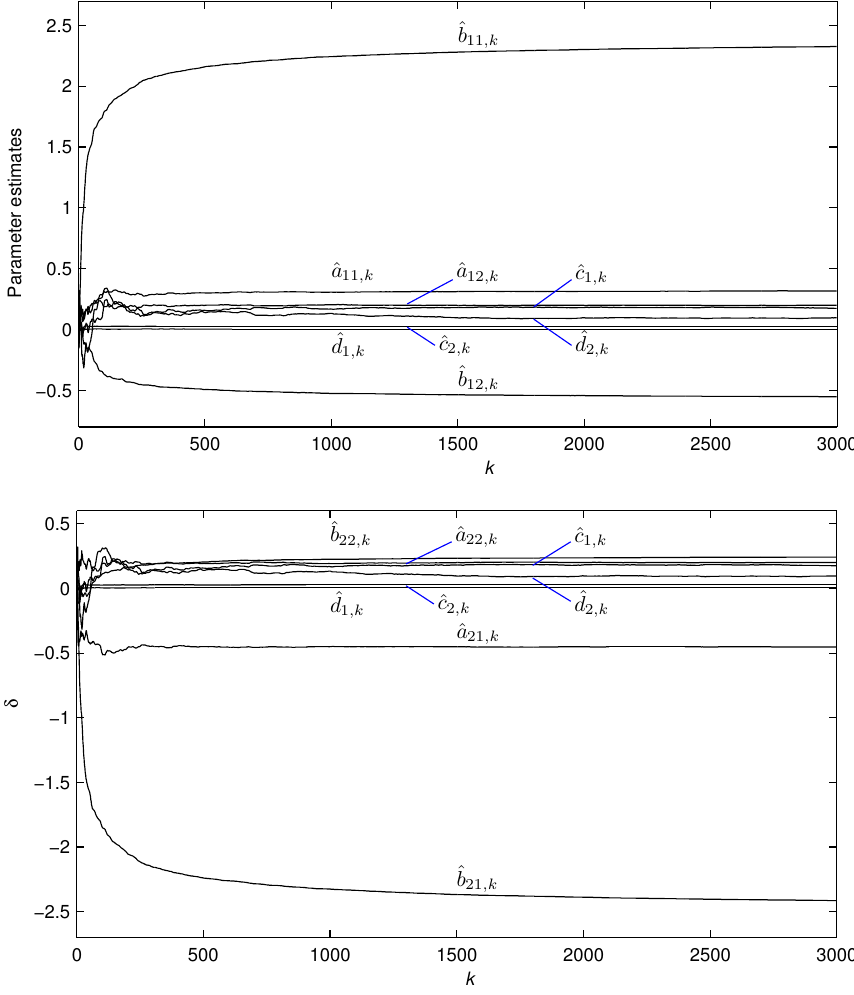
Figure 3. The F-M-ML-MIESG parameter estimates versus k ( σ 2 = 0.10 2 , p =